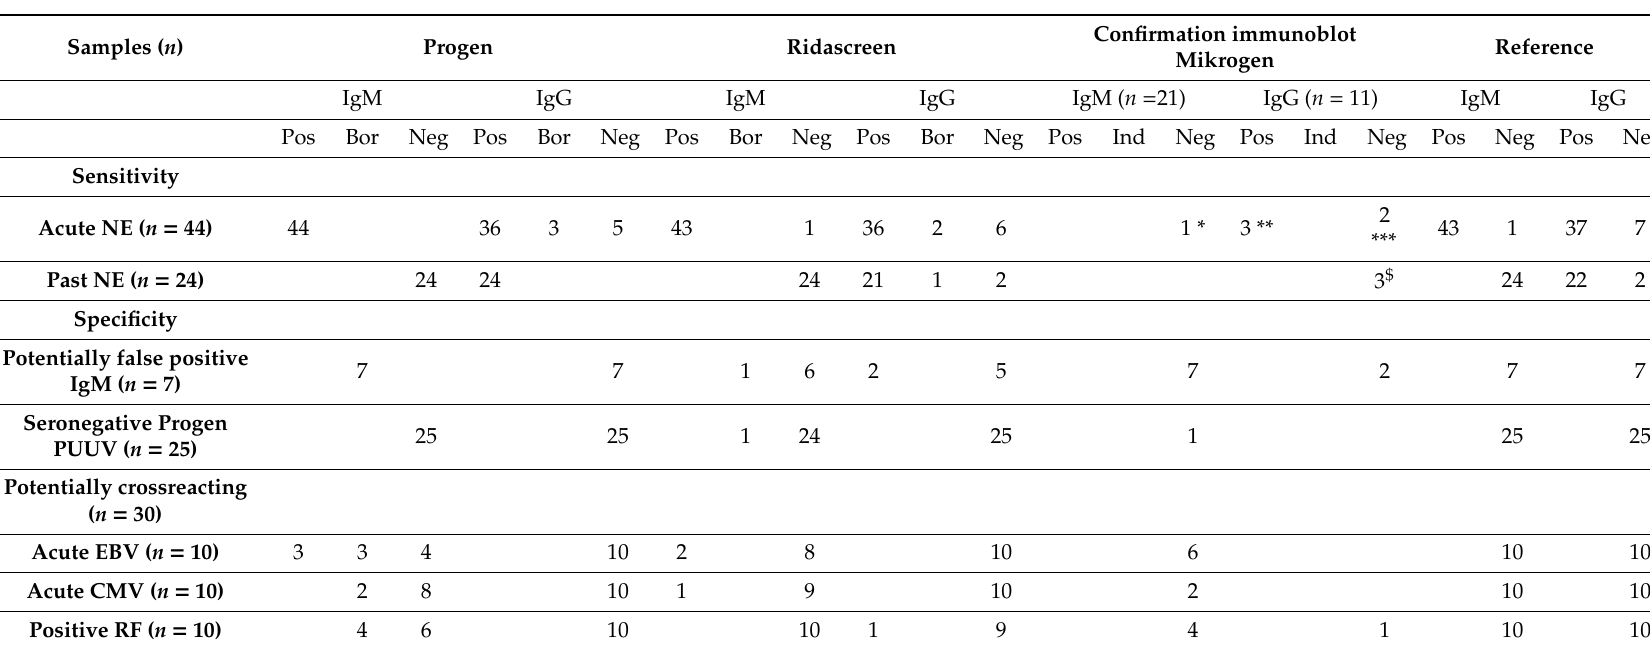
Table 1. Results of Puumala virus IgM and IgG detection on 130 serum samples with Progen and RIDASCREEN ® ELISA and Mikrogen immunoblot. Samples ( n